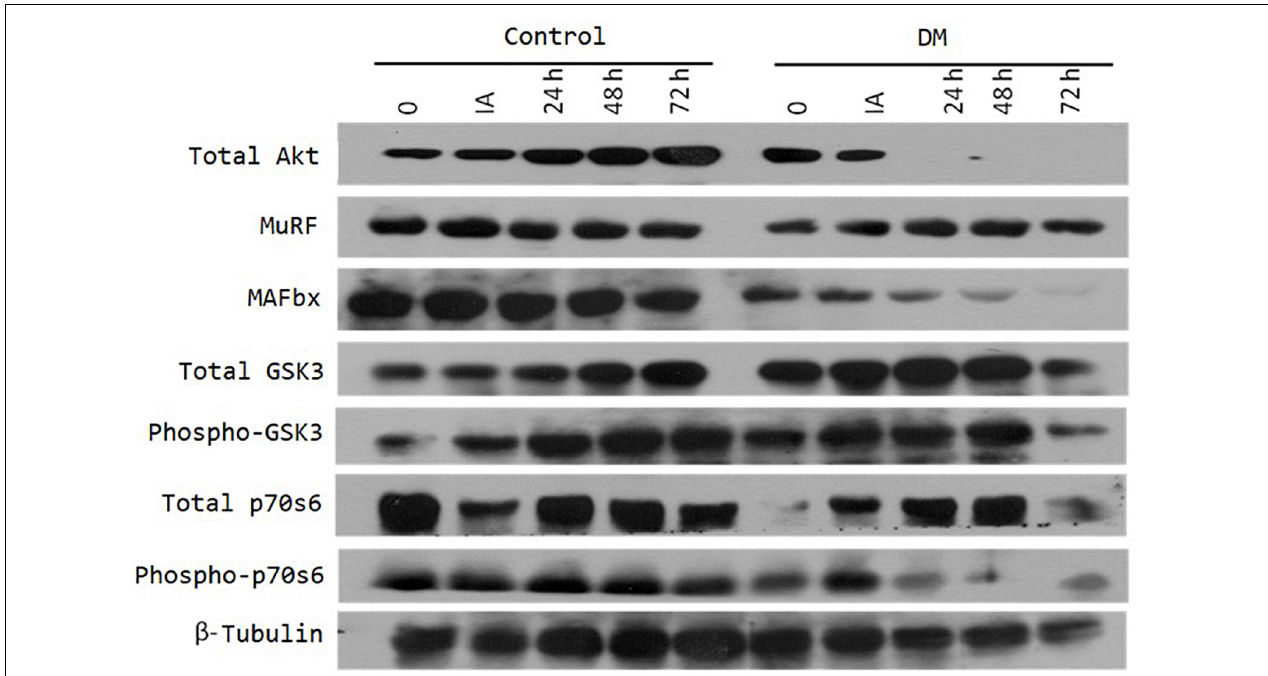
FIGURE 4 | Representative images of Western blots performed with antibodies targeting the following proteins: Akt, MuRF, MAFbx, GSK3, and ap70s6. The soleus muscle of rats from both the control group and the diabetic group were removed before (0), immediately after (IA), and at 2 h (2), 24 h (24), 48 h (48), and 72 h (72) after exercise. Except for Akt, the images represent two experiments that include a pool of four animals per condition. For Akt, the image represents one experiment that included a pool of four animals per